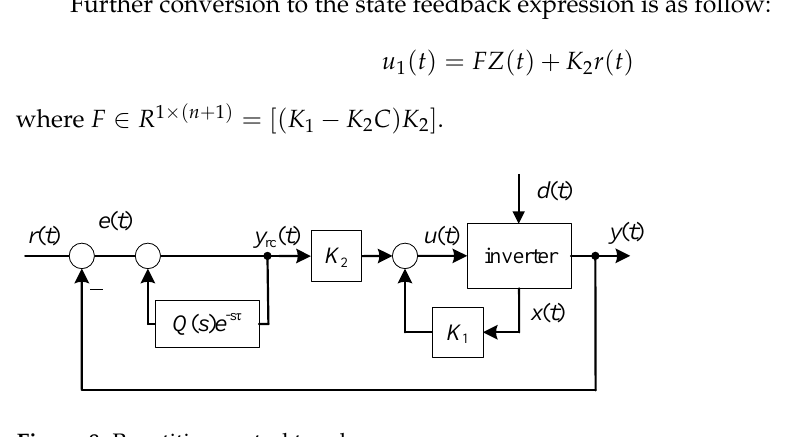
Figure 8. Repetitive control